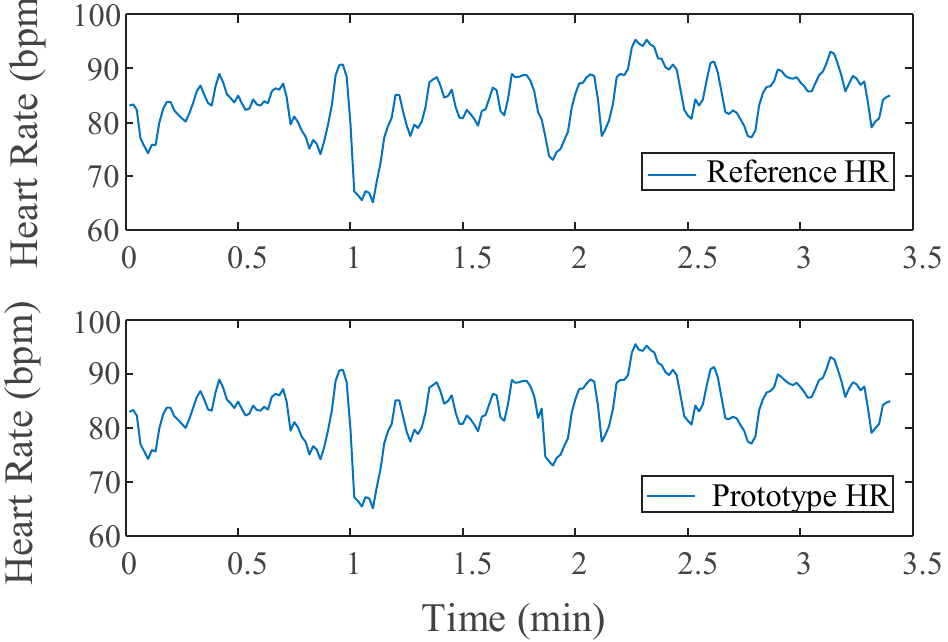
Figure 8. Side by Side comparison of HRV series for Prototype and Reference devices across baseline